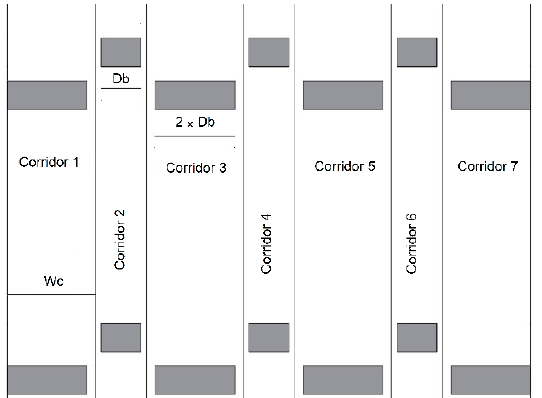
Figure 4. Schematic diagram of boulders and corridors geometry of double rectangular boulder layout (DR3).